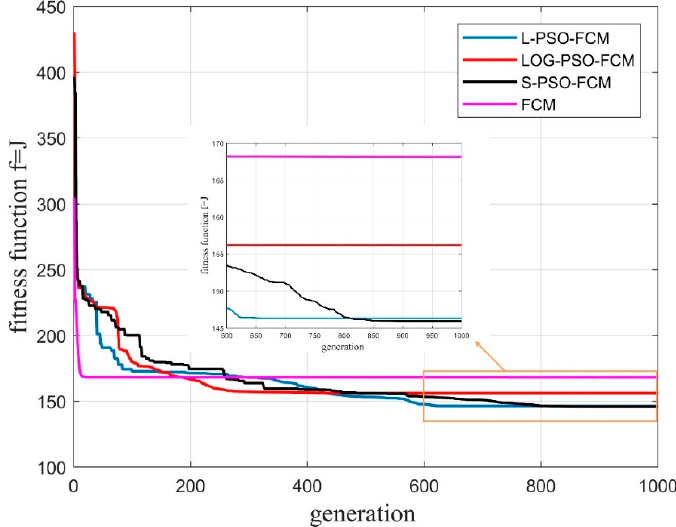
Figure 7. Fitness curves for 1000 generations.